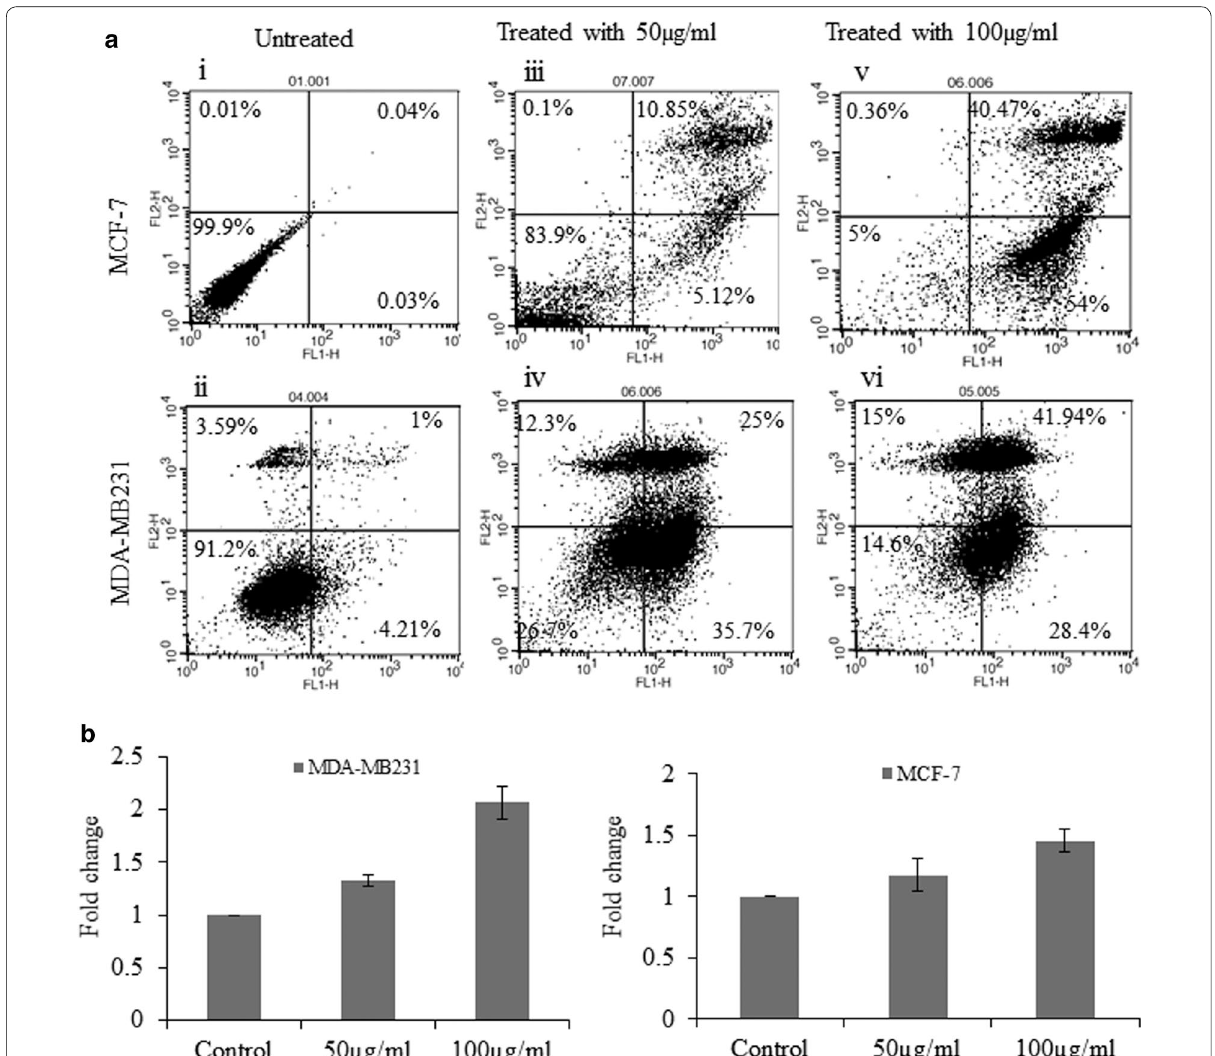
Fig. 4 Apoptototic activity of BTB extract on human breast cancer (MDA-MB231 and MCF-7): a flow cytometry-based Annexin V/PI; ( i , ii ) untreated control, ( iii , iv ) treated with 50 µg/ml and ( v , vi ) 100 µg/ml for 48 h. b Caspase 3/7 activity assay: The data were expressed in fold change with respect to untreated control